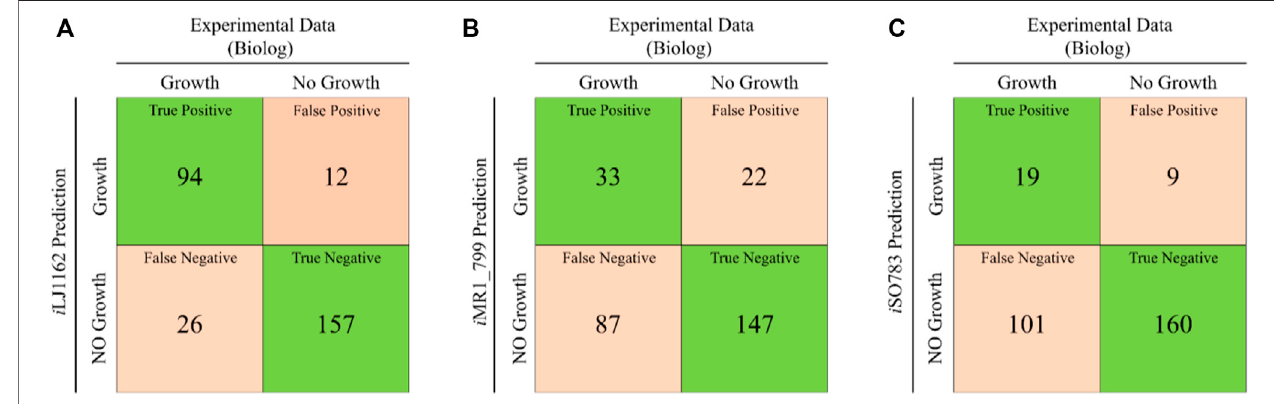
FIGURE 3 | Comparison of in silico simulations and in vivo results for the utilization of various substrates. (A) The comparison results of iLJ1162. (B) The comparison results of iMR1_799. (C) The comparison results of iSO783. Green square represents correct predictions, and orange square represents incorrect